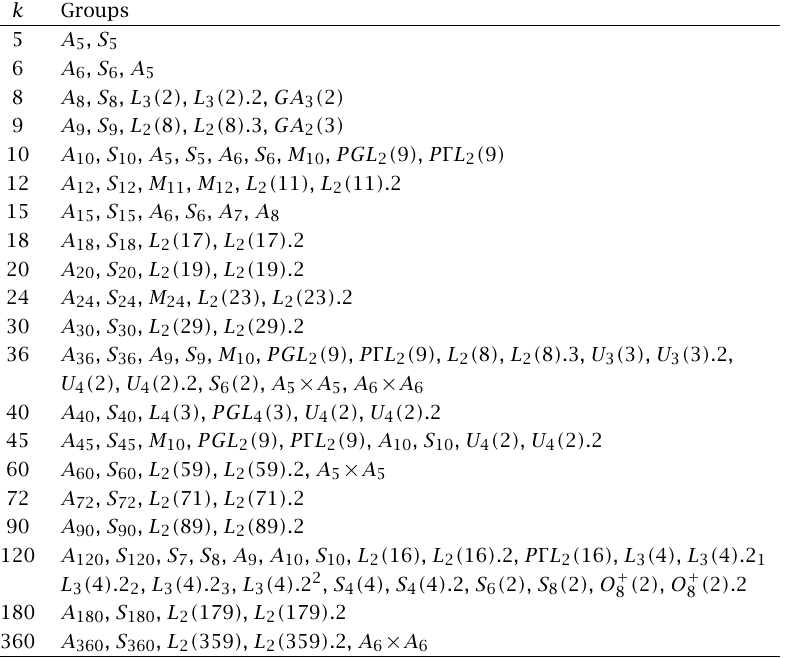
Table 2.1 . Primitive groups of degree k ≥ 5, k |